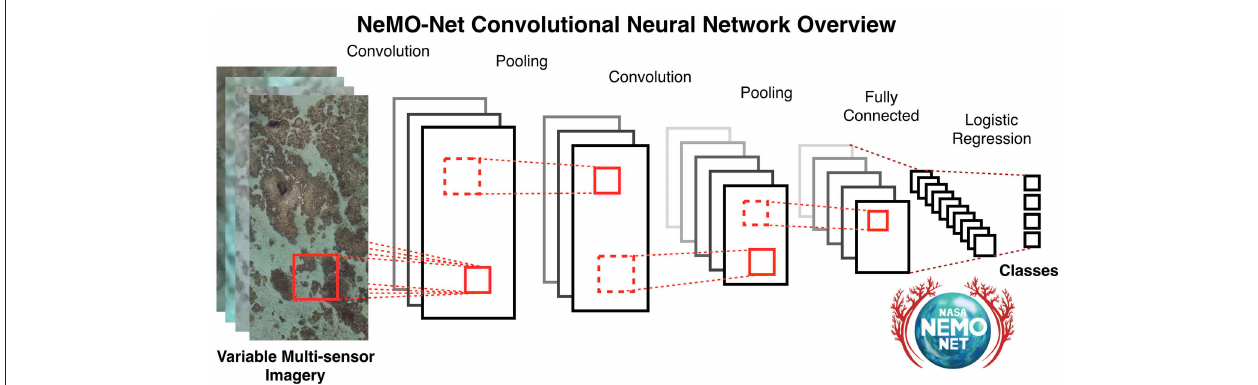
FIGURE 12 | NeMO-Net Convolutional Neural Network (CNN) Overview. NeMO-Net’s CNN is designed to perform multiresolution, multispectral, multitemporal, multisensor feature extraction, and classification for optical remote sensing data. Independent data sources are fed into the CNN, in which convolution, pooling, and fully connected layers are implemented to extract invariant features. Final predictions are made according to logistic regression upon relevant